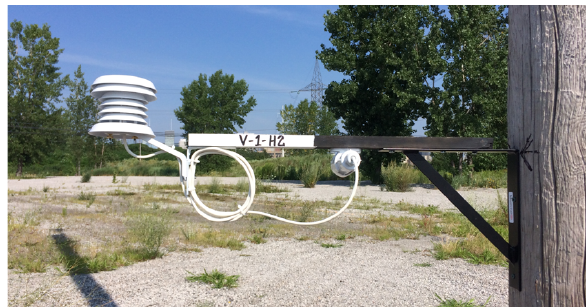
Figure 2. Flights lines over the Montreal’s island; acquired data have to normalized because, due to adverse atmospheric conditions, 6 different days in one month were needed to cover the whole area